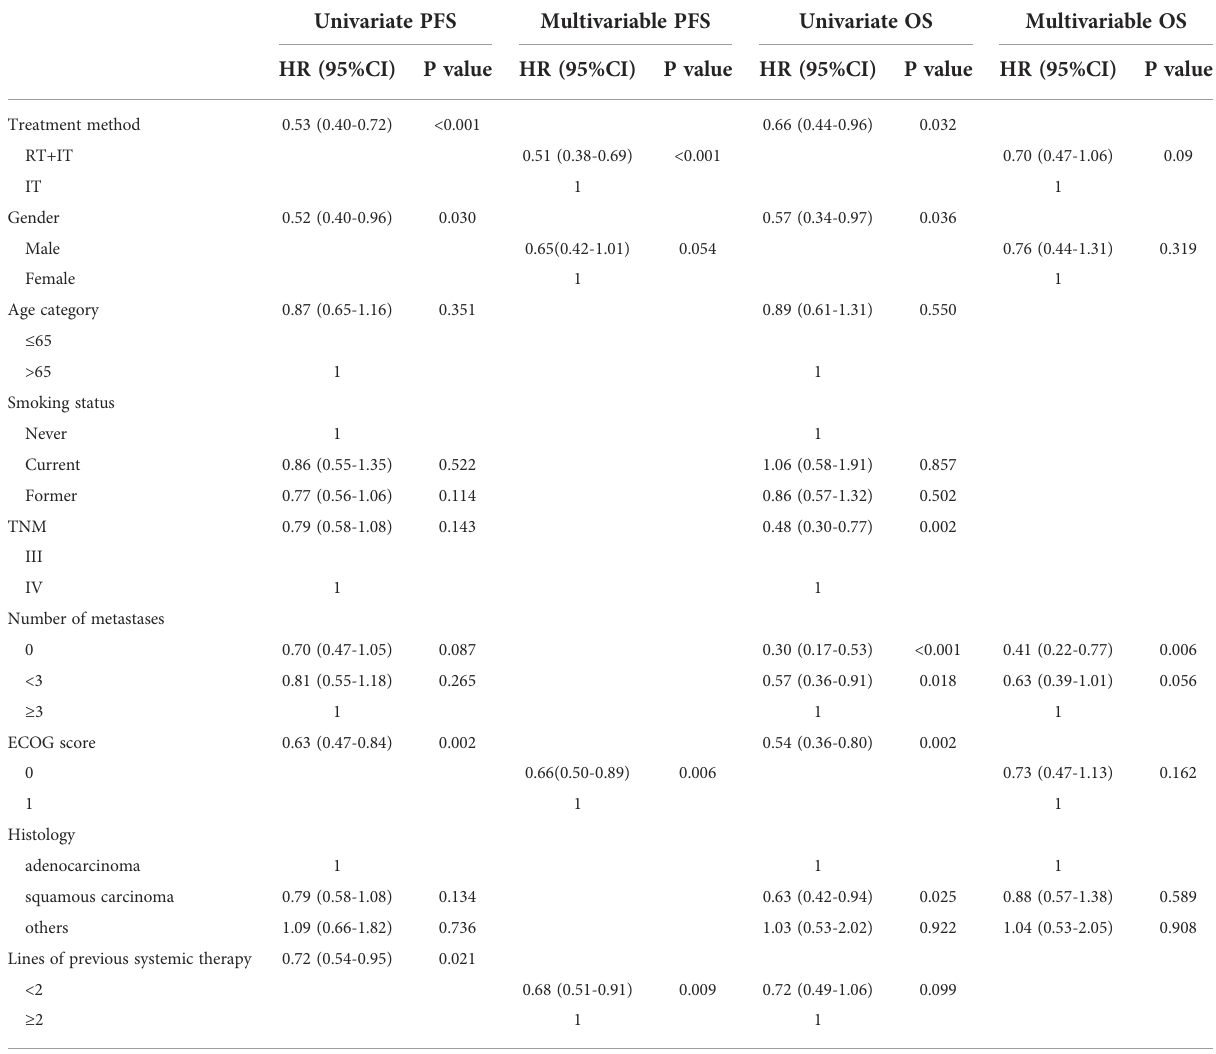
TABLE 2 Univariate and Multivariable cox analysis of progression free survival and overall survival.